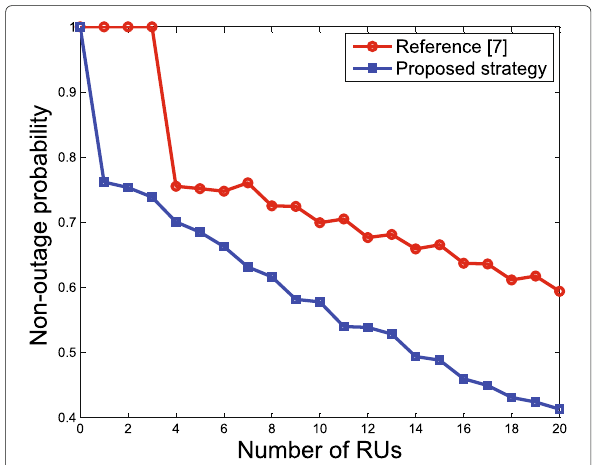
Fig. 10 The relationship between average rate and D2D communication radius under different transmission strategies. This figure illustrates the average rate and r under four different transmission strategies when a file request